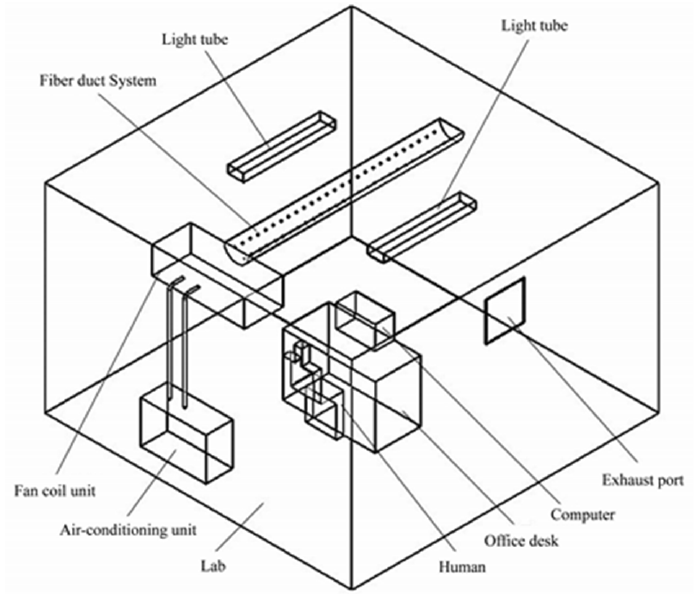
Figure 2. The schematic diagram of the structure of the room.